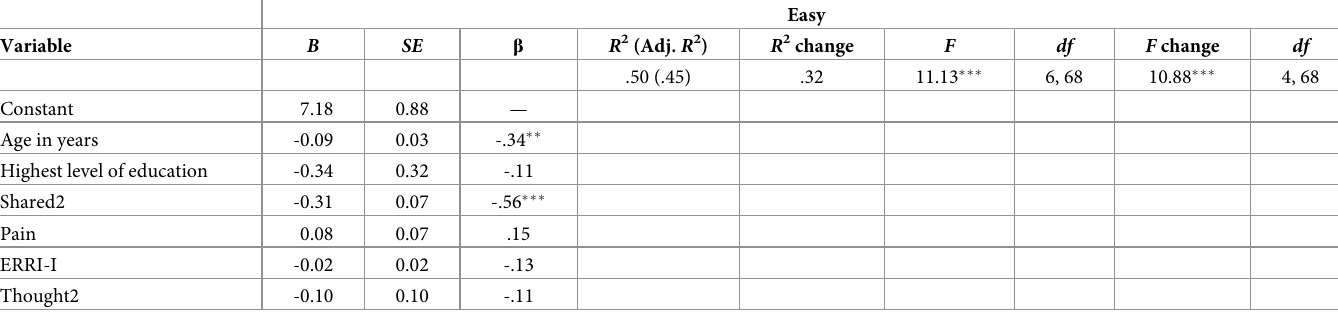
Table 6. Final hierarchical multiple linear regression model on identity fusion with mothers who have had an easy birth.